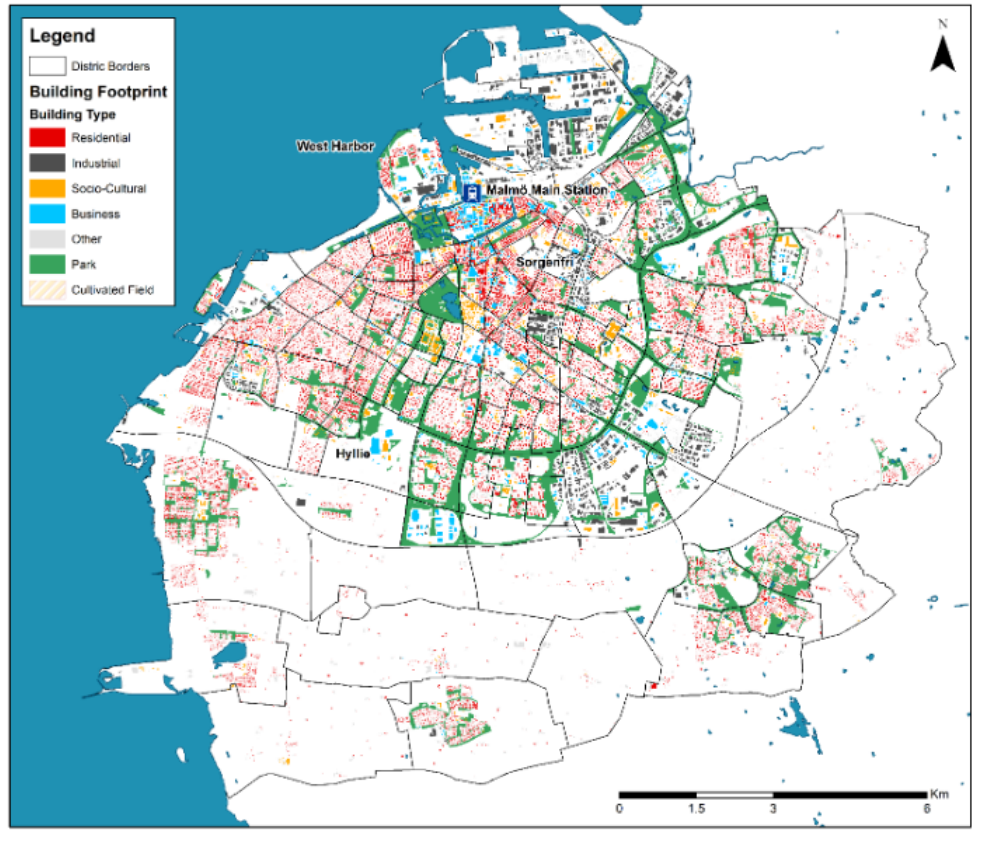
Figure 2. Malm¨o map